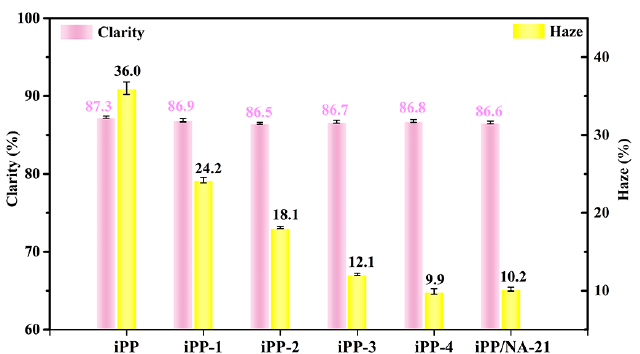
Figure 9. The optical performances for the iPP/A12C-Li composites.